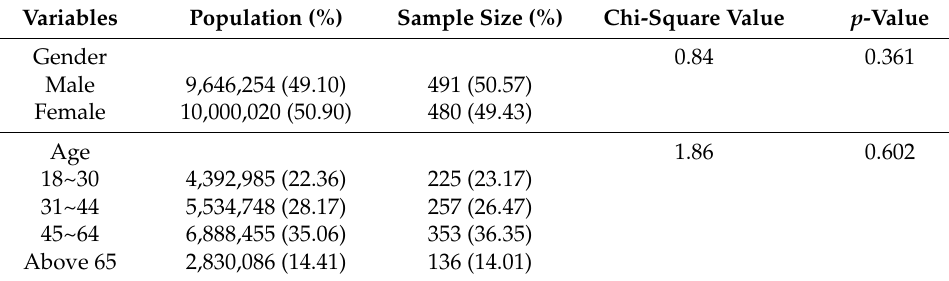
Table 1. Chi-square fitness test results for sample